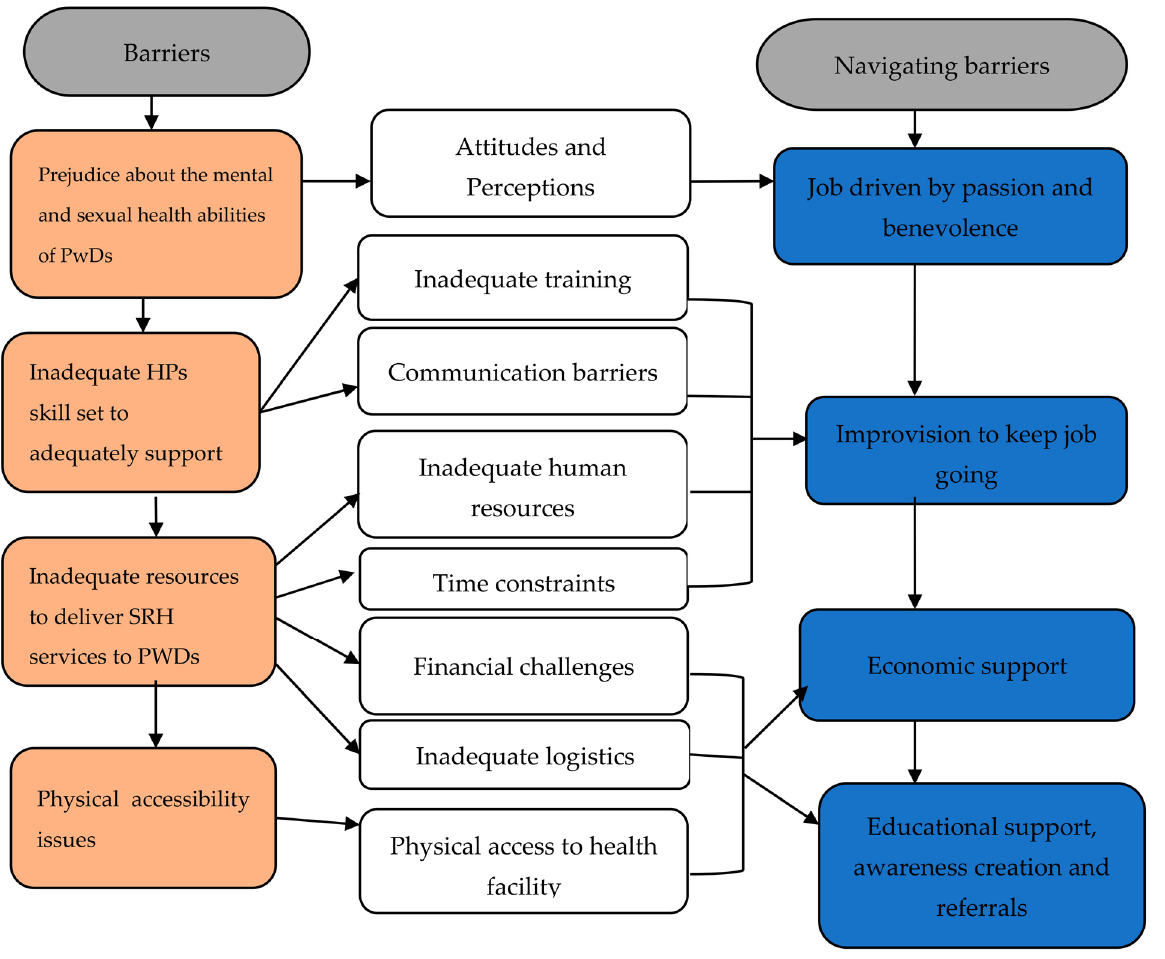
Figure 4. Themes emerging from the data and their interrelationships.